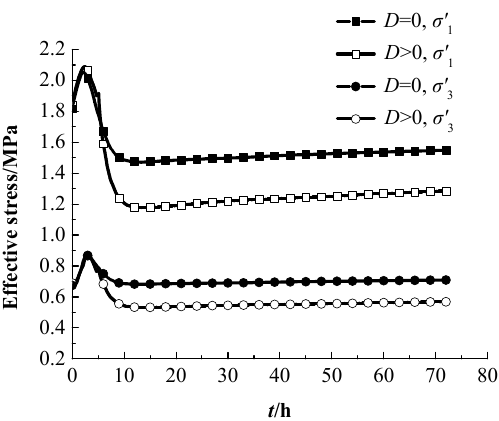
Figure 15. Curves of the effective stress of Point F with and without considering damage of hydrate-bearing sediments.